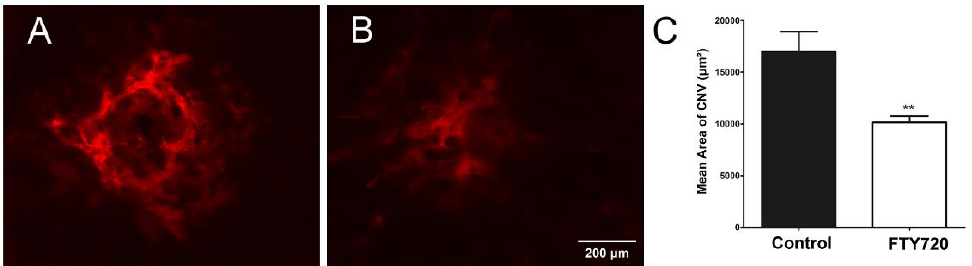
Figure 9. A single intravitreal injection of the S1PR agonist FTY720 inhibits CNV in a mouse model of nAMD. C57BL/6j male and female mice (2 months old) were injected intravitreally with ( A ) vehicle